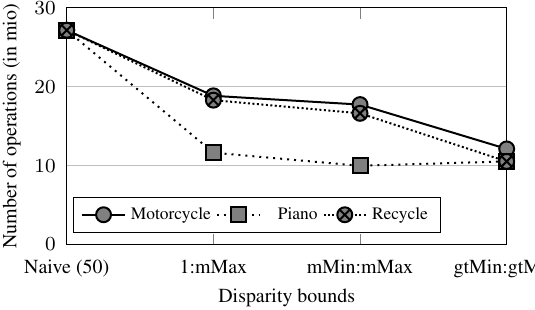
Figure 8. Number of operations as a function of disparity